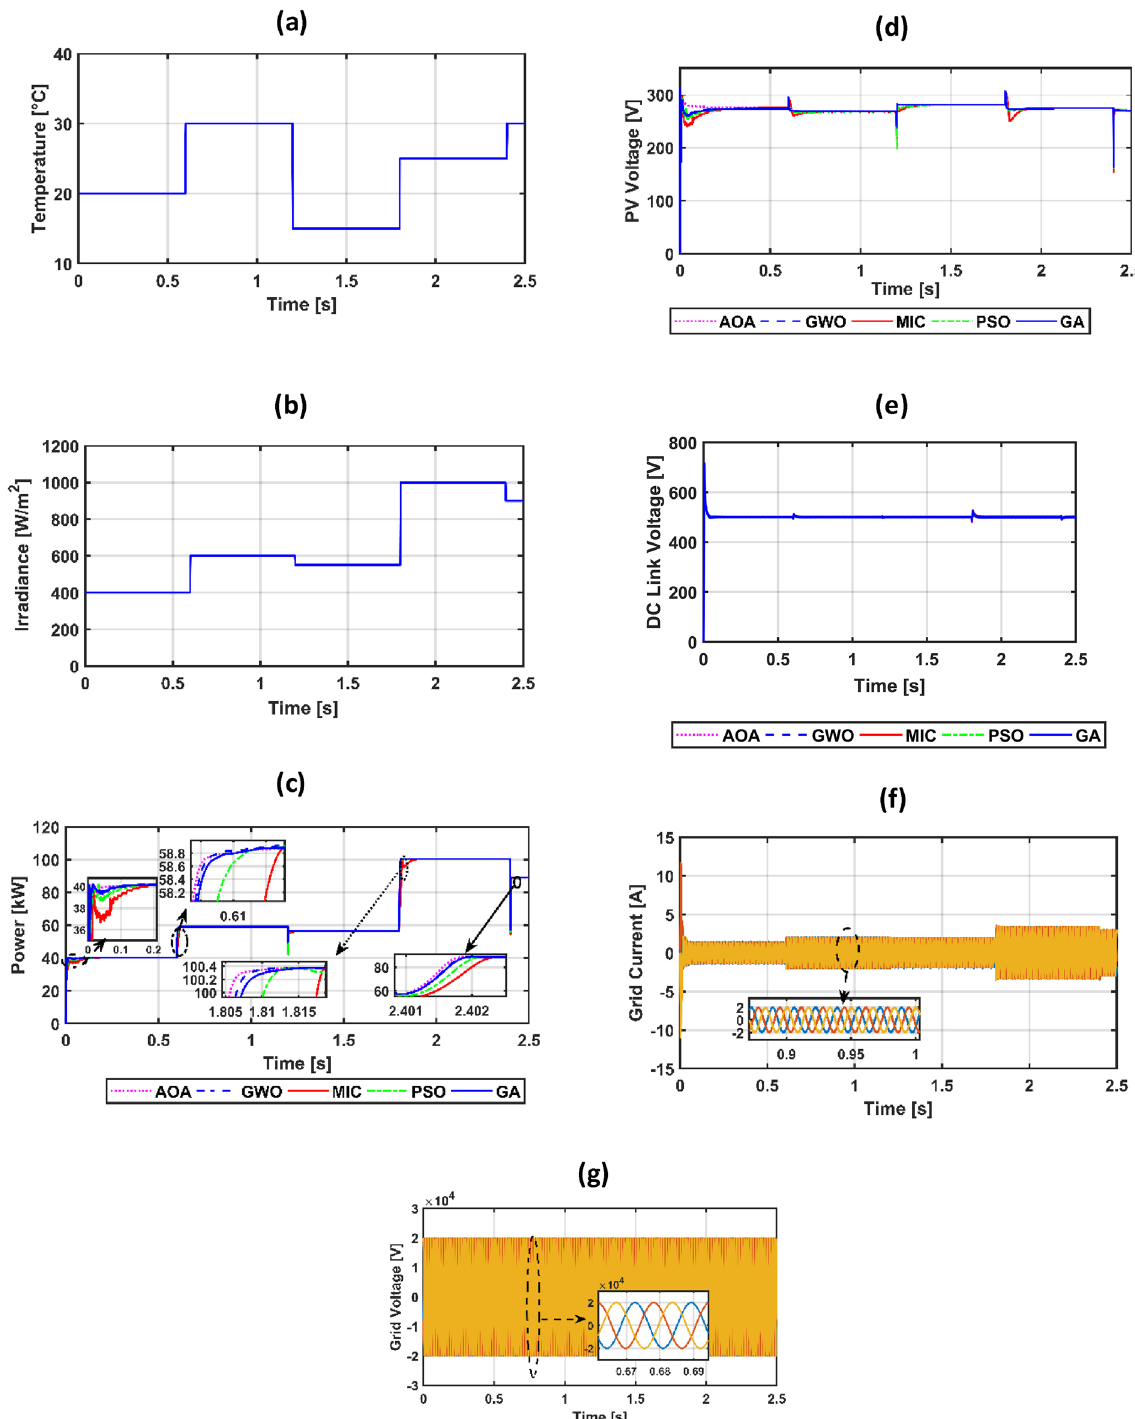
Figure 13. ( a ) variable temperature Level pattern, ( b ) variable Irradiance Level pattern, ( c ) PV power, ( d ) PV voltage, ( e ) voltage of DC link, ( f ) grid current-based AOA, ( g ) grid voltage-based